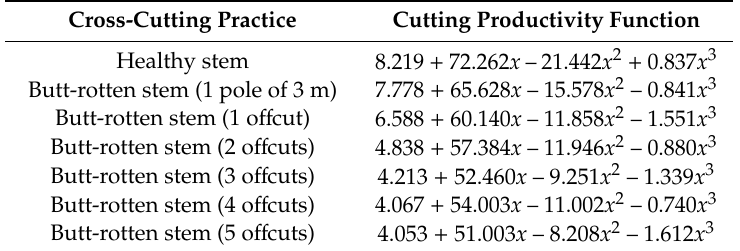
Figure 4. Calculated effective hour productivity curves of the cutting work (Table 5) and change in the cutting productivity by cross-cutting practice compared to cross-cutting practice two (Zero level = cutting of one pole of 3 m) as a function of the stem volume. Table 5. Effective hour productivity functions of the cross-cutting work of the stem.